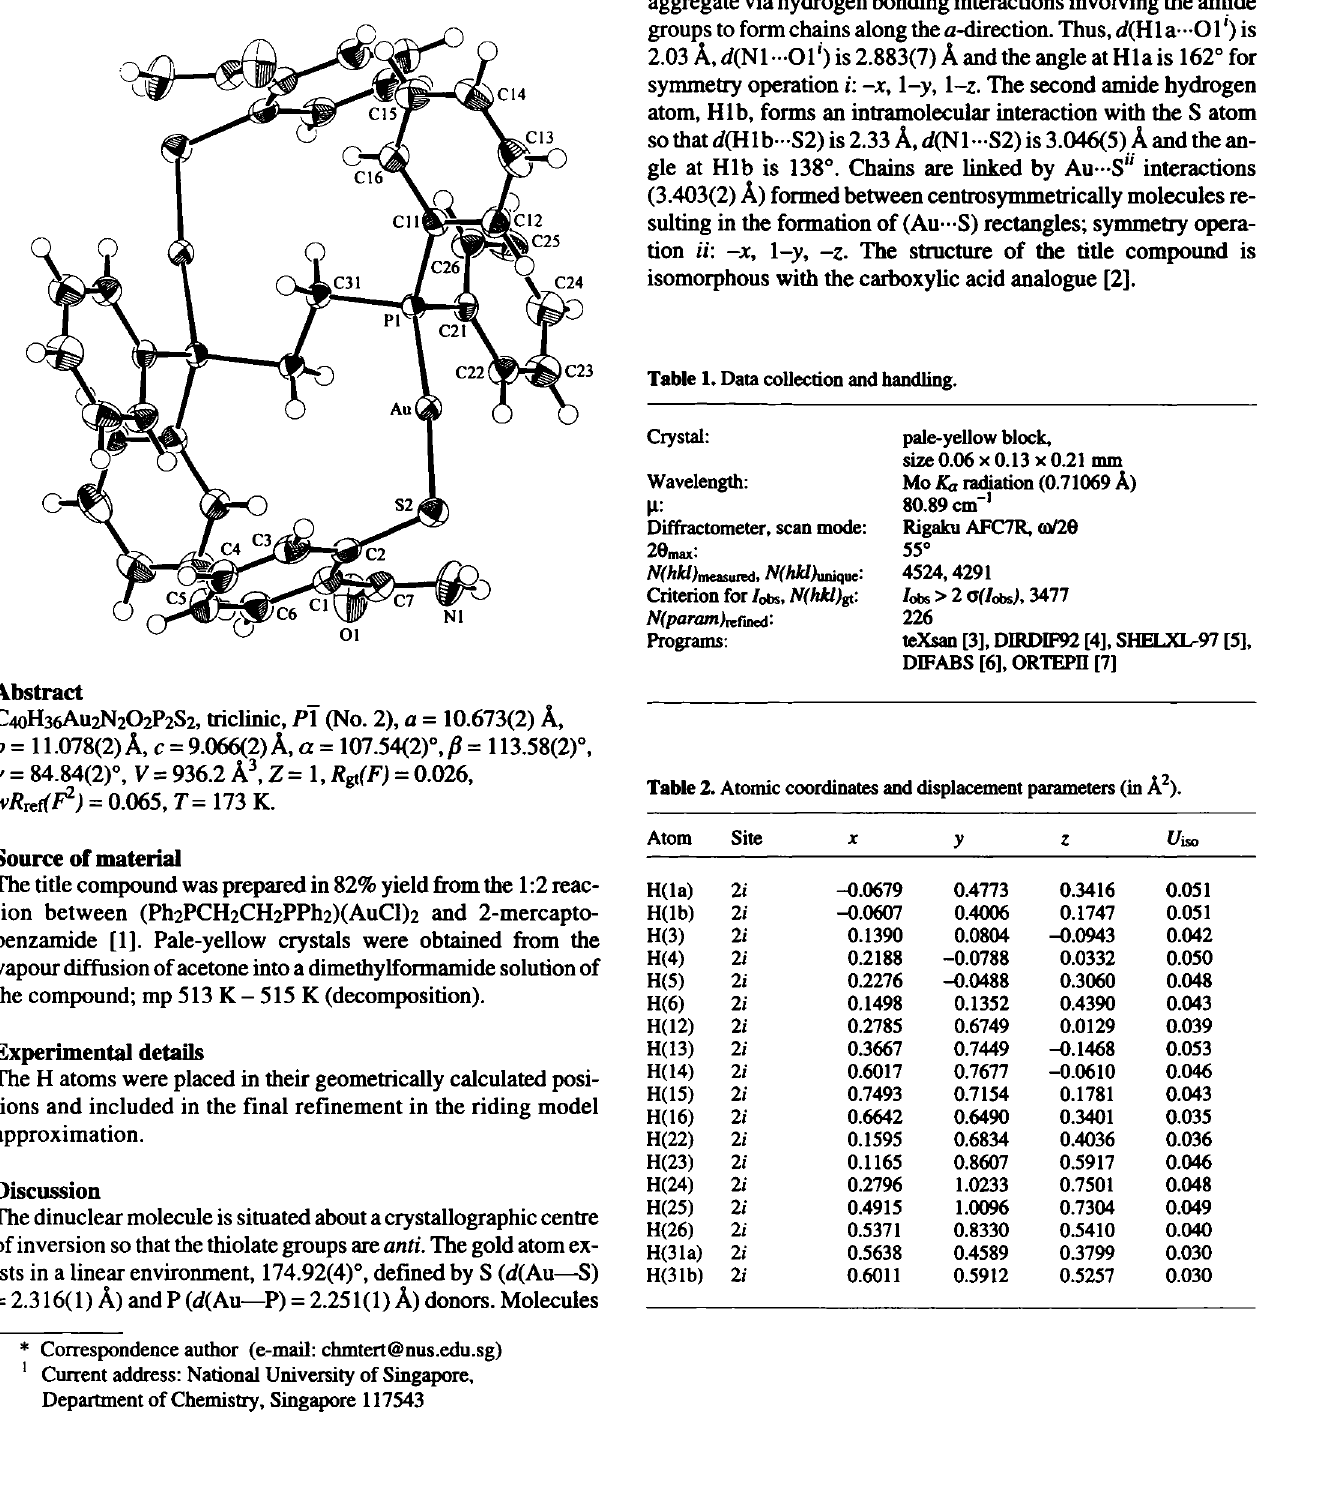
Table 2. Atomic coordinates and displacement parameters (in Â 2